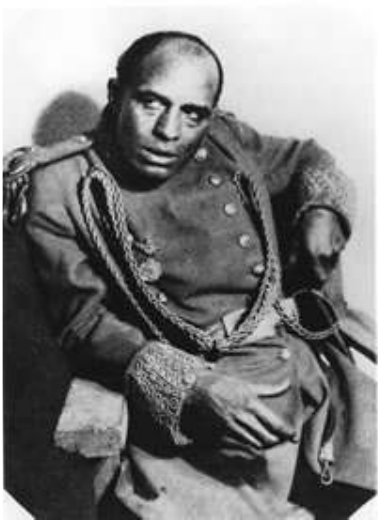
Figure 1: Charles Gilpin in The Emperor Jones